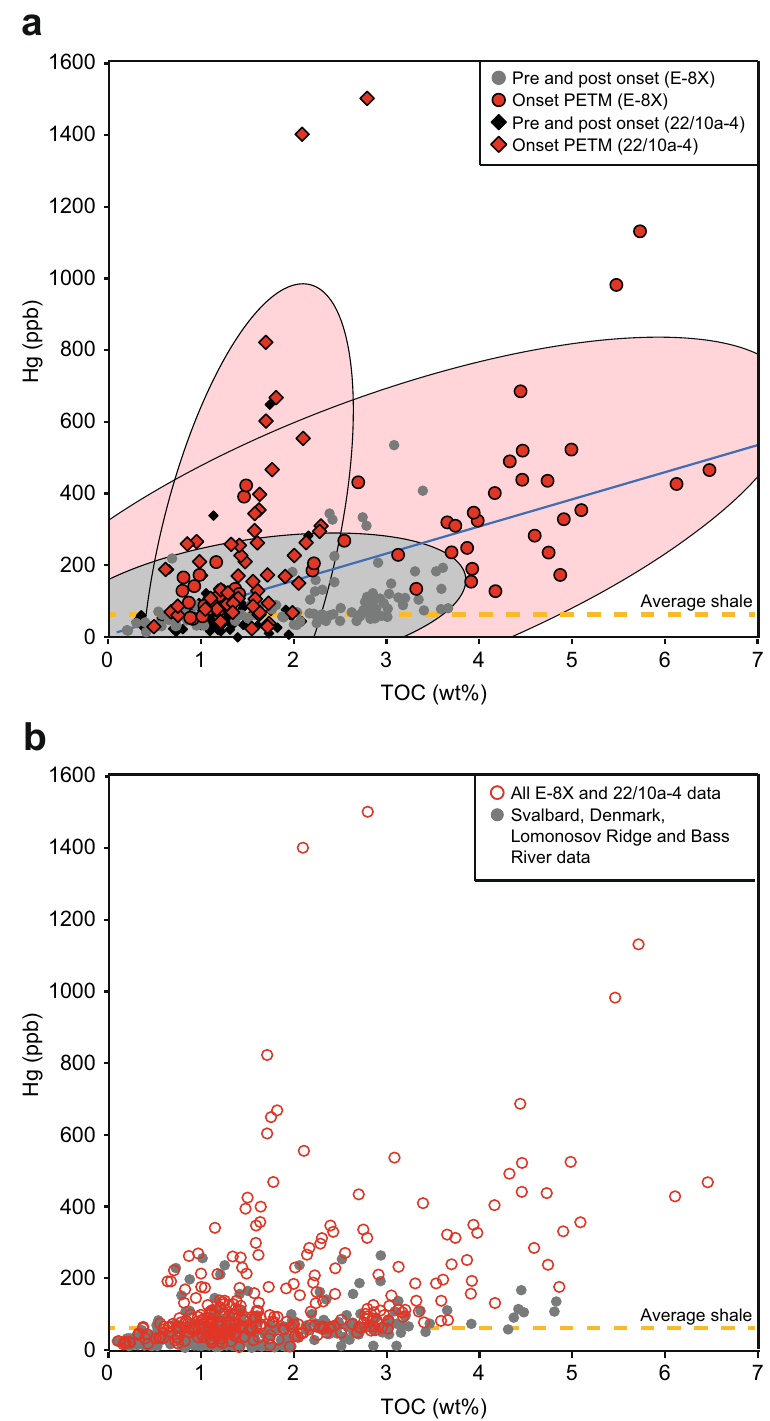
Fig. 4 Sedimentary Hg (ppb) against TOC (wt%) for well sites E − 8X and 22/10a − 4 and other published records. a Line is the linear regression of E − 8X and 22/10a − 4 datasets combined ( R 2 = 0.22). Samples immediately before, during and after the Paleocene – Eocene Thermal Maximum (PETM) onset are indicated as red symbols (~2024.6 – 2026 m for E − 8X; ~2608 – 2615 m for 22/10a − 4), and outside of that area with grey symbols. Shaded 95% ellipses show the changing relationship between Hg and TOC over the studied interval, with many samples within the PETM onset (red symbols) exhibiting excess Hg with a steeper gradient to TOC than samples outside of this interval (grey symbols). Well site 22/10a − 4 appears to have experienced greater excess Hg than E − 8X, possibly as it was closer to the North Atlantic Igneous Province source. The dashed line shows the value of the average Phanerozoic bulk shale 34 . b All data from E − 8X and 22/10a − 4 (red symbols) plotted with data from Svalbard BH9/05, Denmark Fur formation, Lomonosov Ridge and Bass River (grey symbols) 7